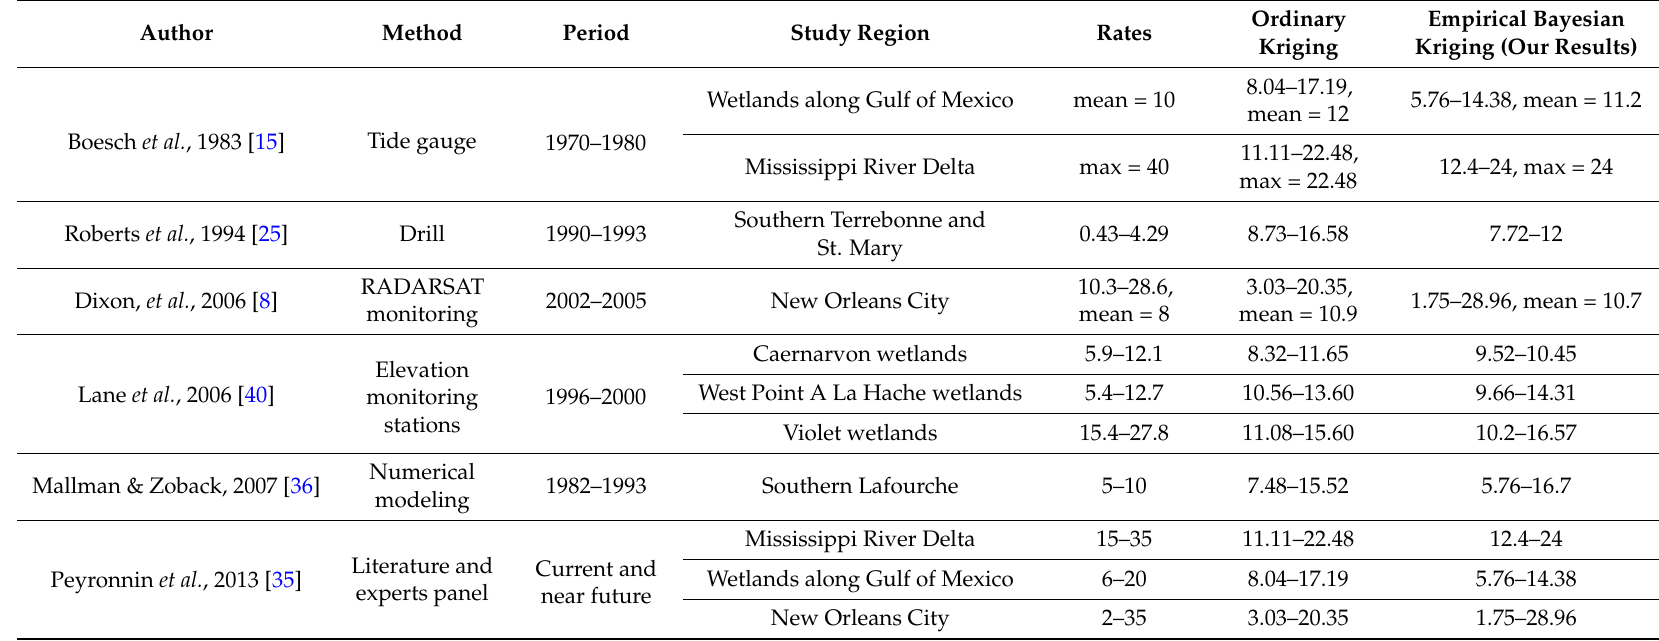
Table 2. Subsidence rates (in mm/year) from the literature and our